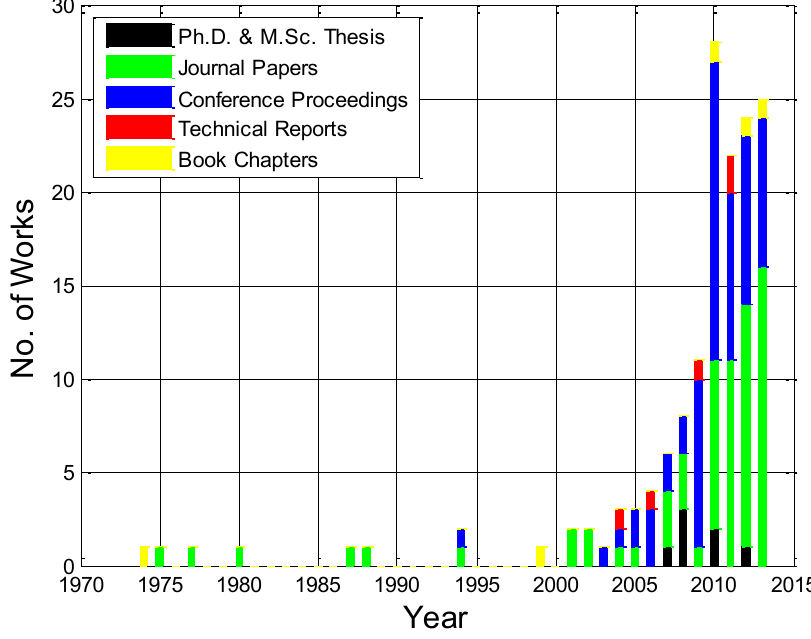
Figure 1. Timeline of Scientific Works Related to the WFDO